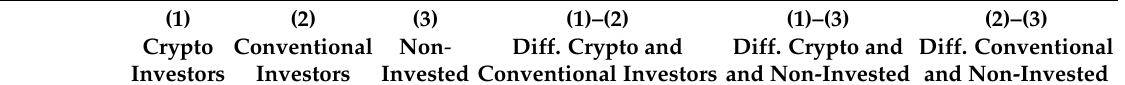
Table 3. Means and t -tests of crypto owners, conventional and non-investors of characteristics and behavioral traits. Source: Own